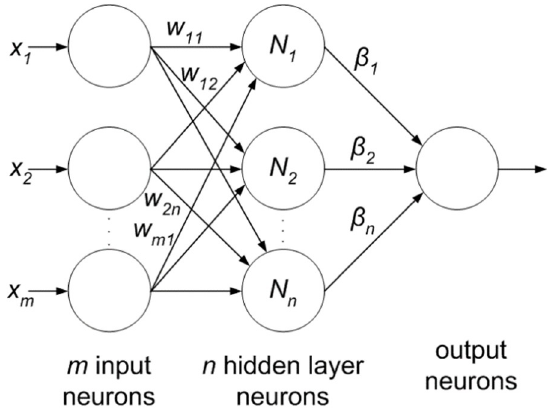
Figure 10. Extreme learning machine.